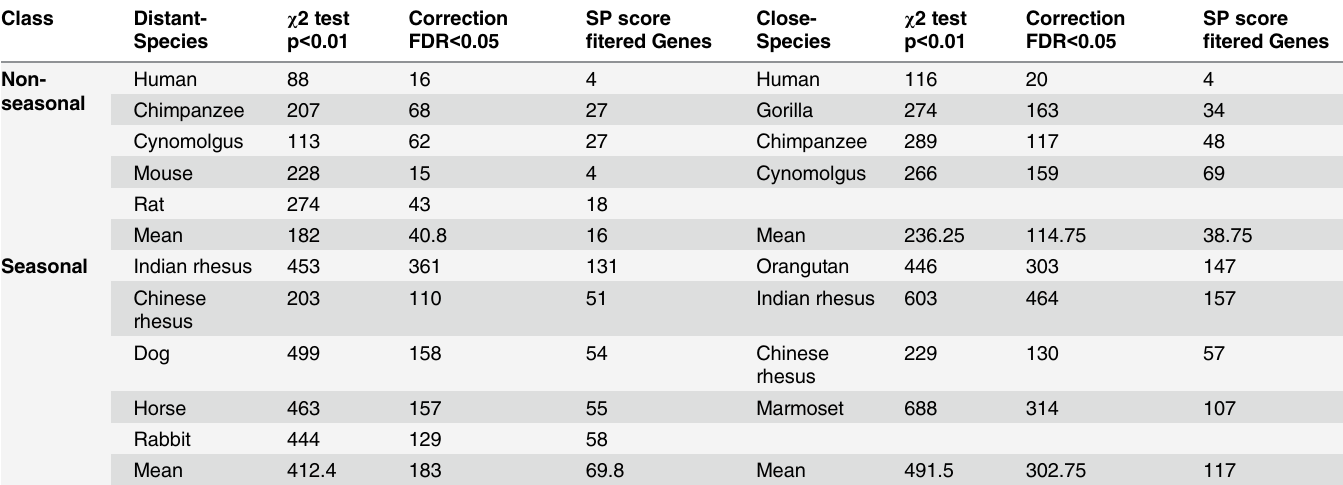
Table 1. Numbers of positively-selected genes under different filtering conditions.